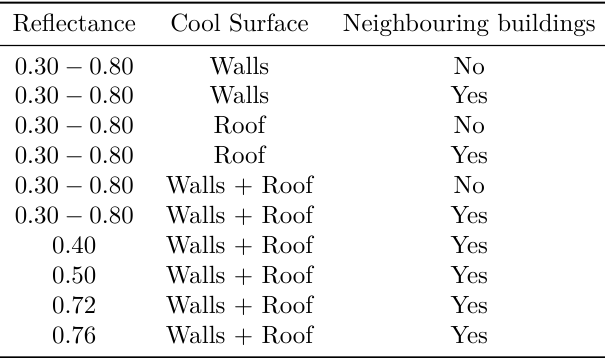
Table 1. List of building simulations for each location.